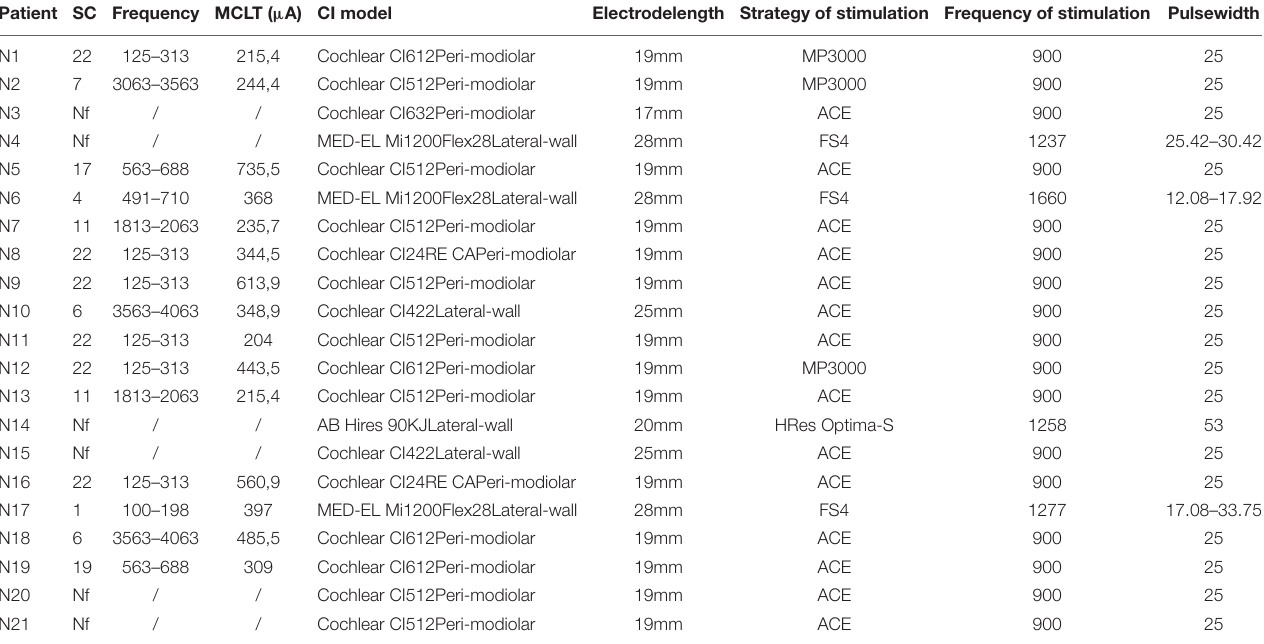
TABLE 2 | Detection of cochlear regions most involved in the attenuation/suppression of tinnitus: electrical channel with the greatest attenuation capacity on tinnitus in each patient [suppressive channel (SC)]; minimum current level suppressing tinnitus (MCLT) ( µ